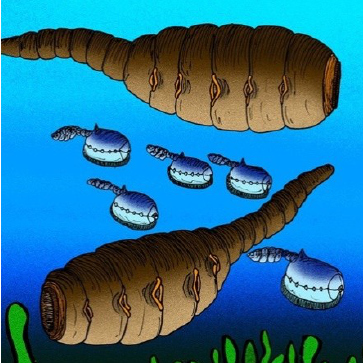
Figure 13. Yuyuanozoon magnificissimi with smaller Vetulicola rectangulata swimming behind. PaleoArt credit: Apokryltaros. Used here per CC BY-SA 3.0.